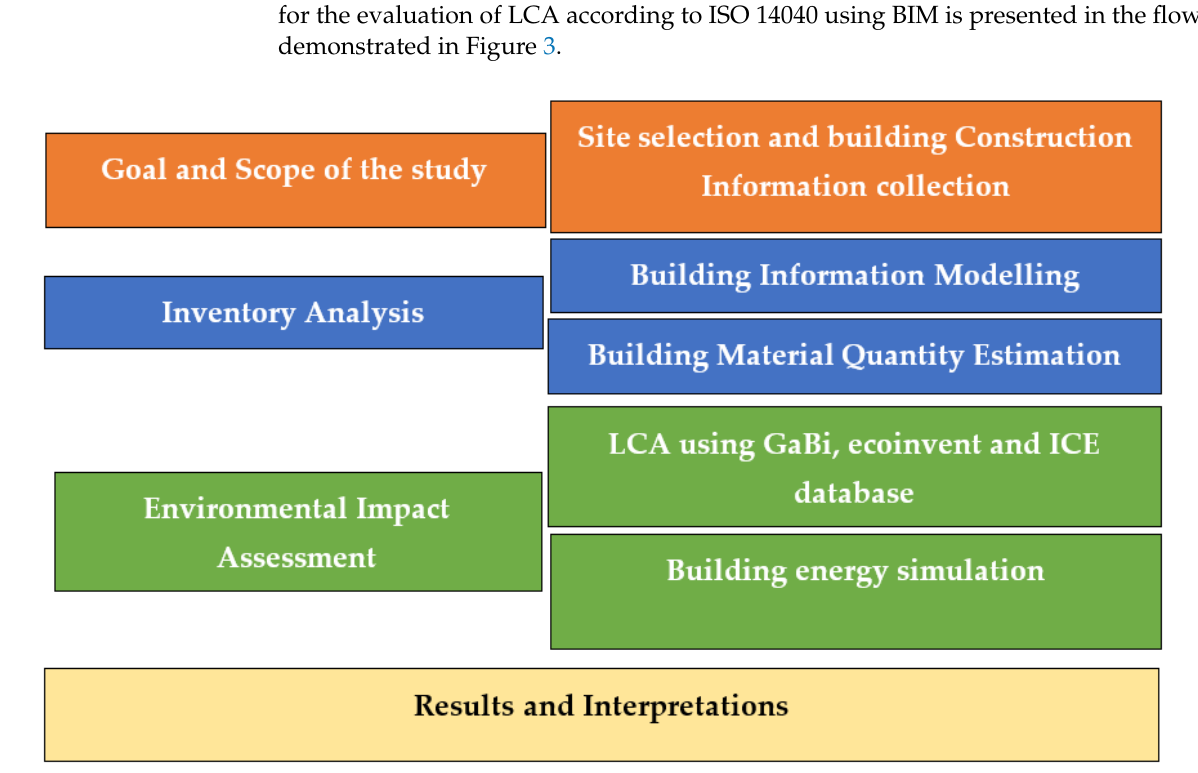
Figure 3. Flow chart of the methodology.